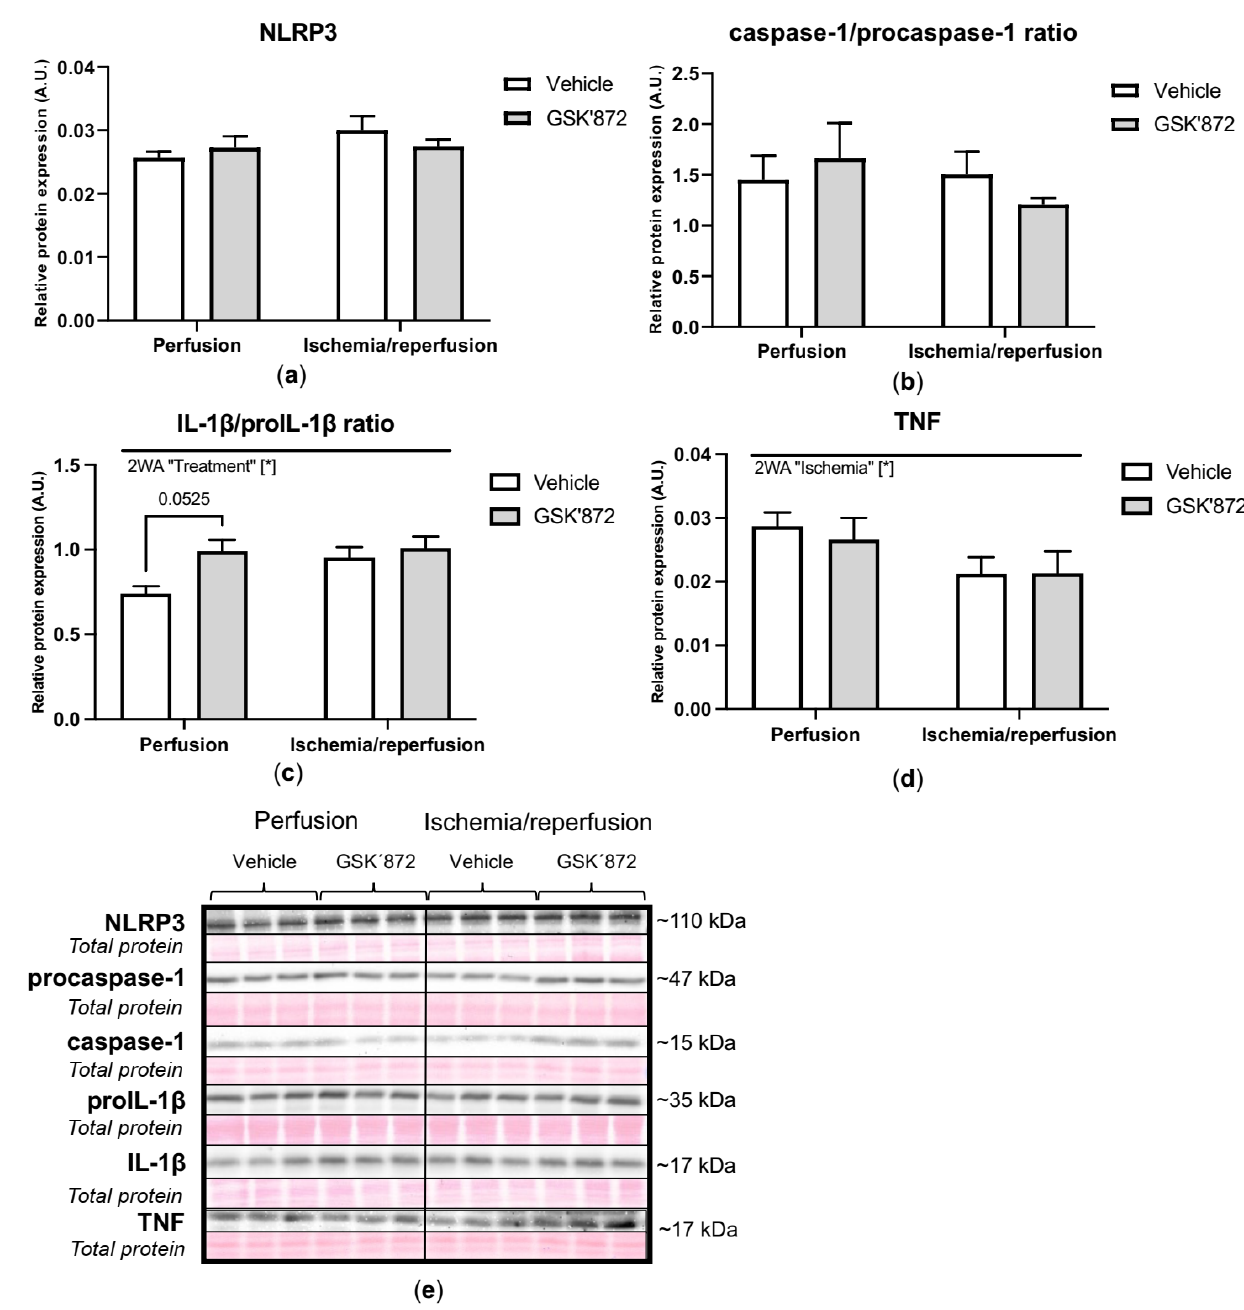
Figure 7. Analysis of inflammation in left ventricles lysates; immunoblot quantification of NLRP3 ( a ), caspase-1/procaspase- 1 ratio ( b ), IL-1 β /proIL-1 β ratio ( c ), TNF ( d ); representative immunoblots and total protein staining ( e ). Data are presented as mean ± SEM; * p < 0.05. 2WA—two-way ANOVA; “Ischemia”—presence of ischemia/reperfusion; “Treatment”— presence of